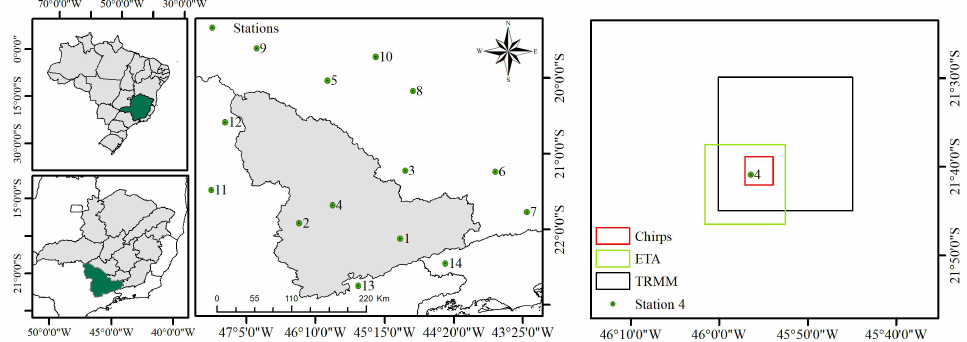
Figure 1. Spatial locations of meteorological stations ( left ) and relative pixel sizes of the rain data products ( right